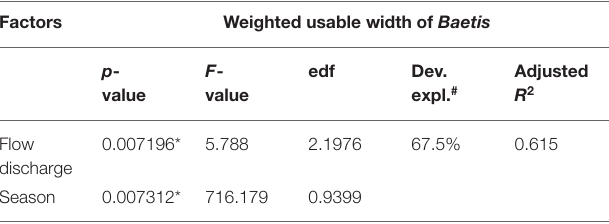
TABLE 2 | Generalized additive model results of the relationships between the habitat suitability of Baetis and the flow discharge and seasonal factors. Factors